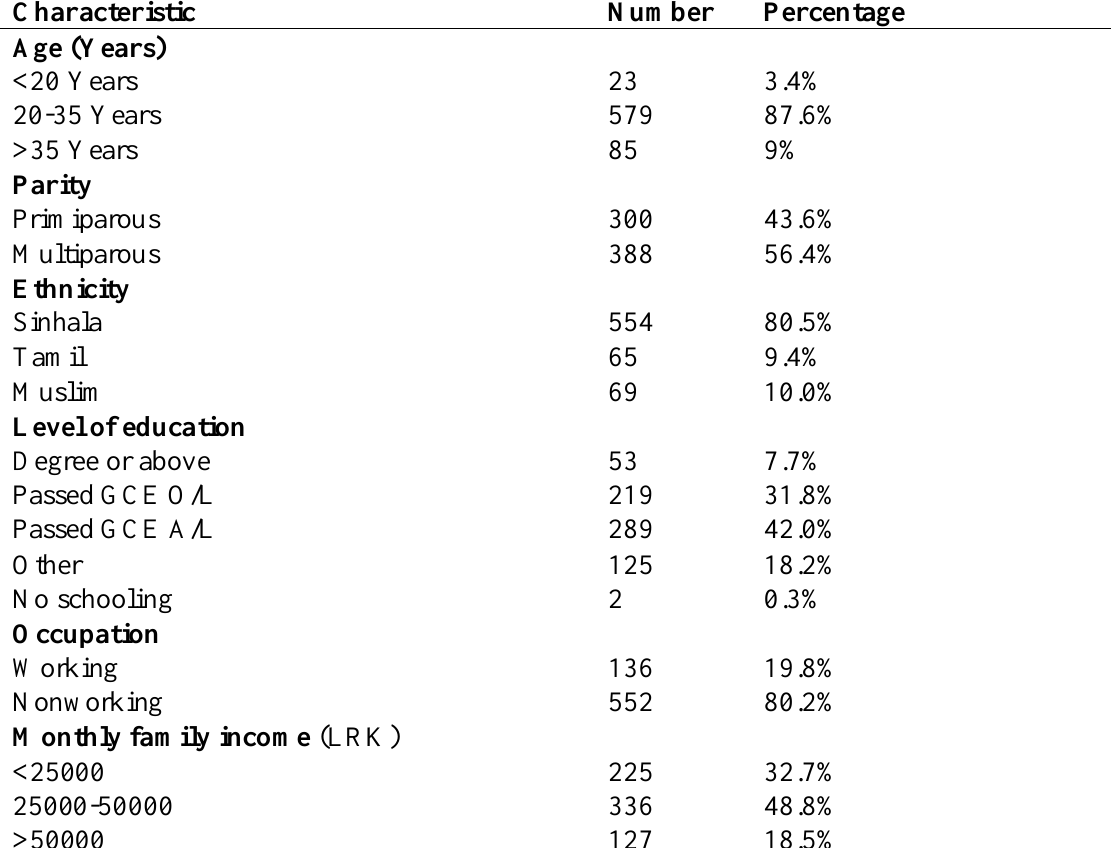
Table 01 - Distribution of maternal sociodemographic and obstetric characteristics